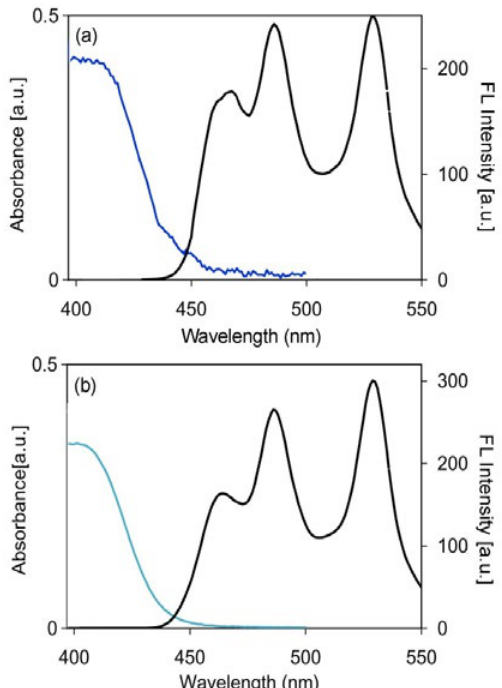
Fig. 6. UV-Vis and fluorescence spectra of (a) L- and (b) D-cyst- CdS-QDs. Excitation wavelength for all fluorescence spectra is 388 nm.